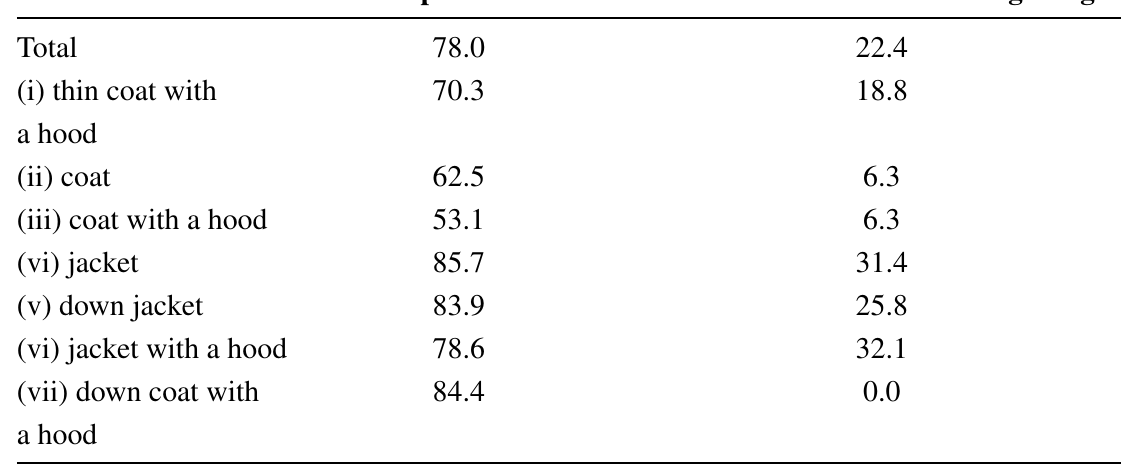
Table 3. Correct classification rate with CASIA-B-CL by the proposed method and the method without matching weights [ % ].